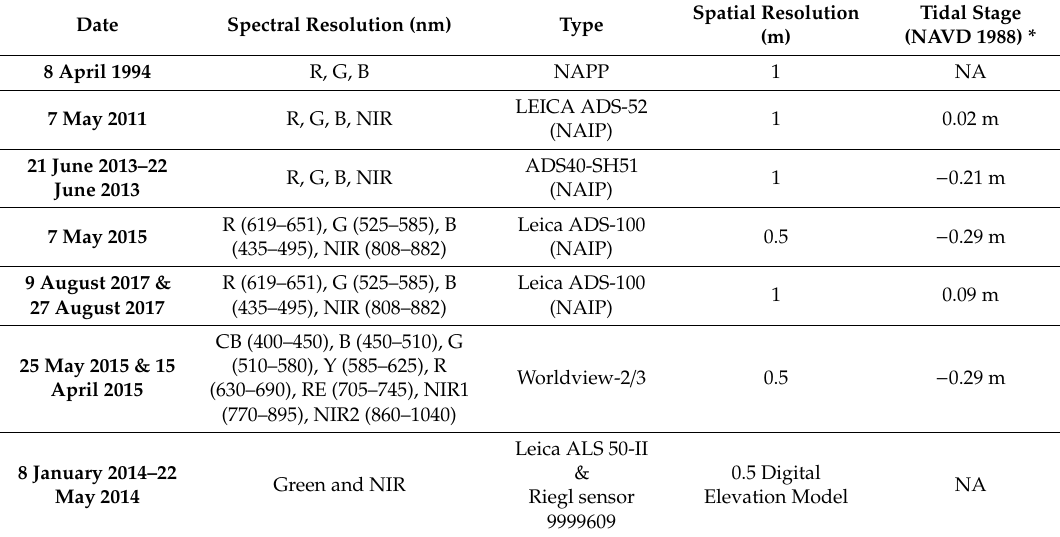
Table 1. The description of data used by acquisition date, spectral resolution (band wavelength when available), sensor or program, and spatial resolution. R = red, G = green, B = blue, NIR = near infrared, CB = coastal blue, Y = yellow, RE = Red